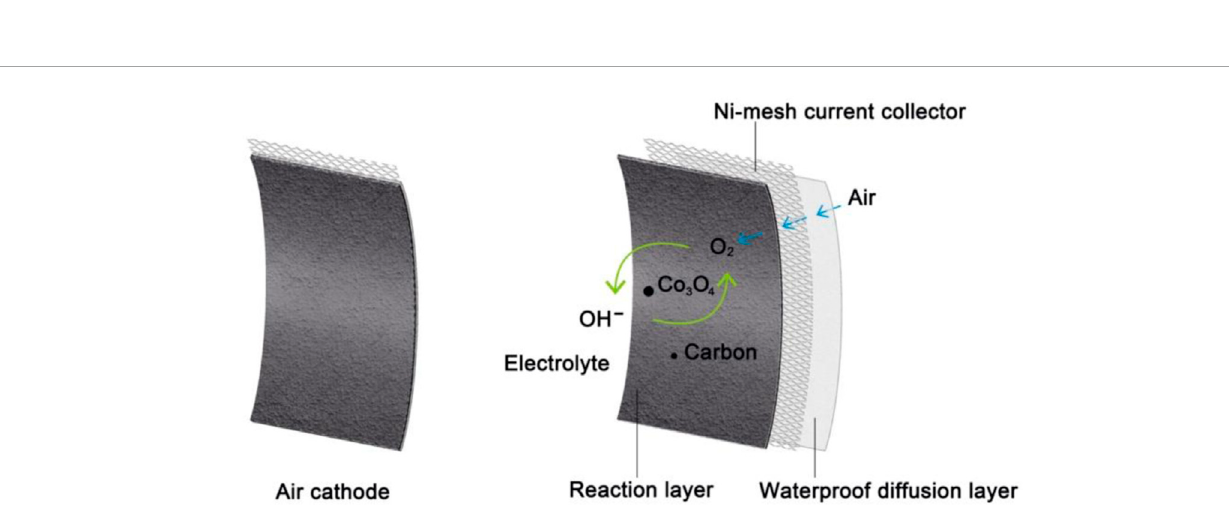
FIGURE 2 Schematic diagram of Co 3 O 4 /CB air cathode.